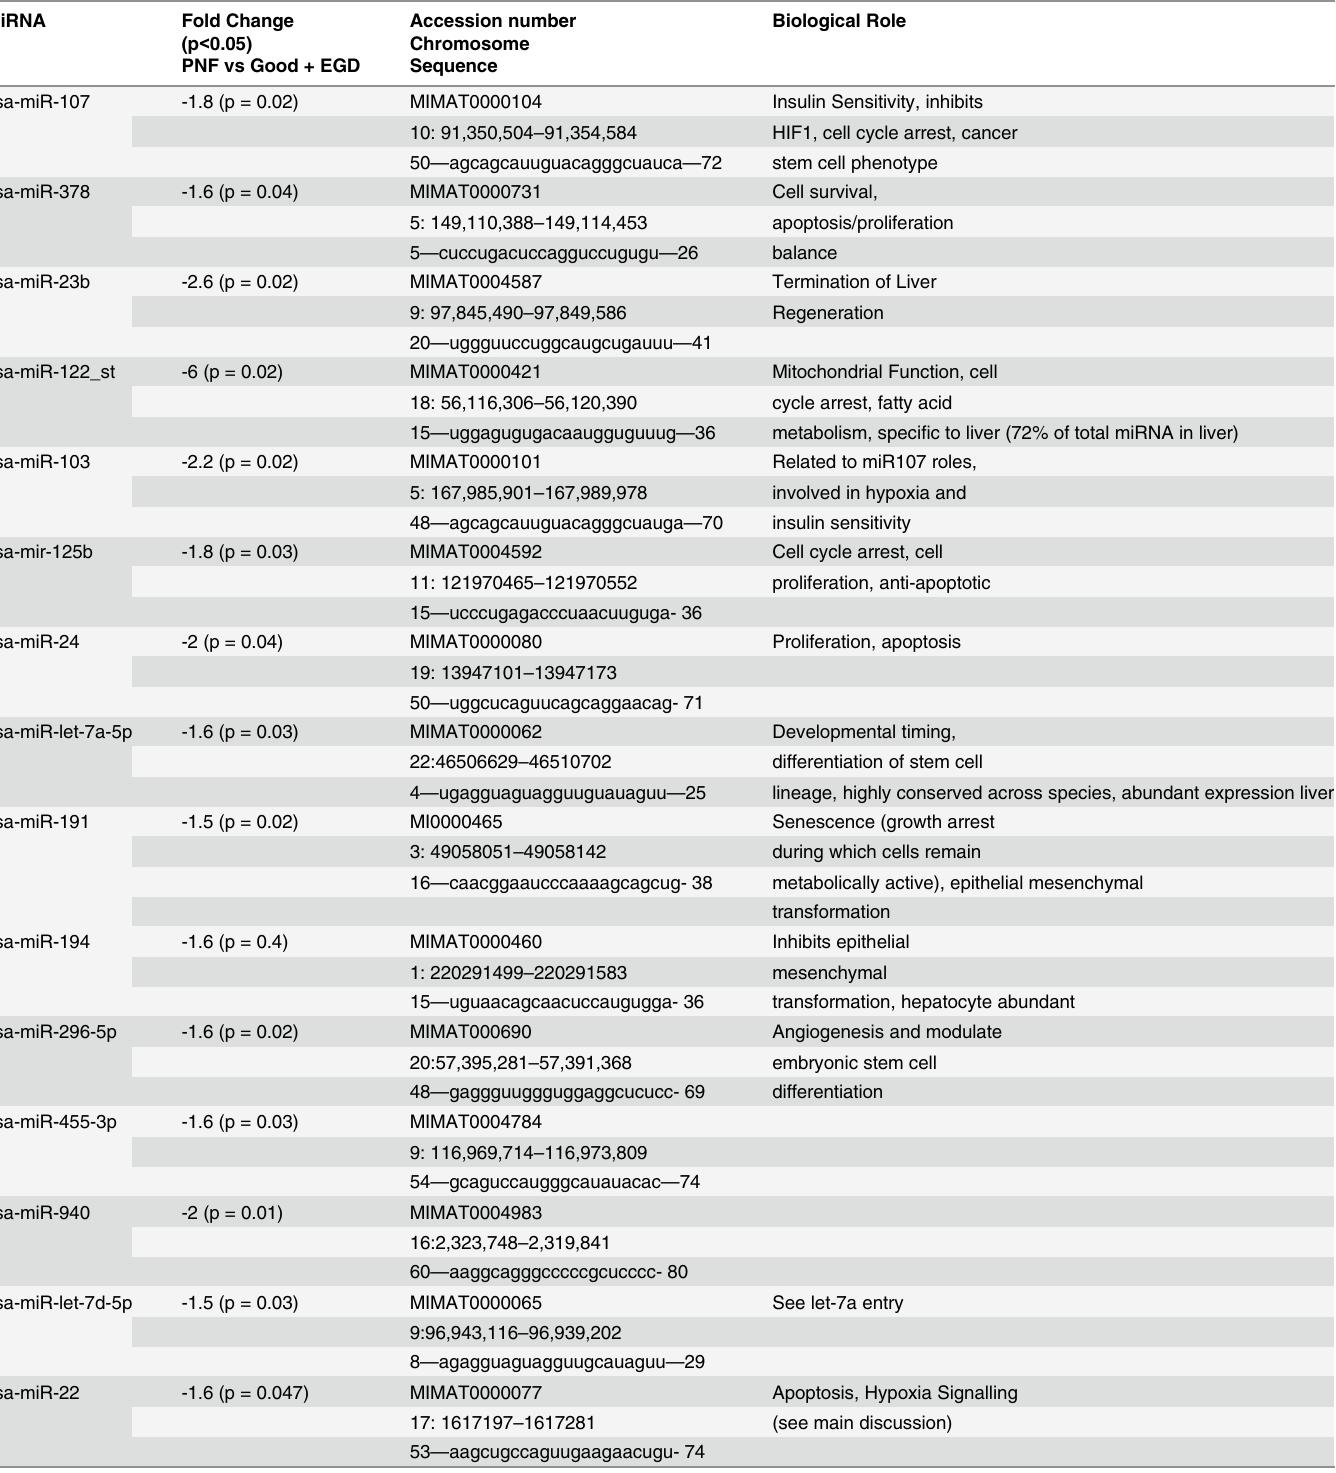
Table 2. Summary of microRNA with differential expression between the donation after cardiac death groups.